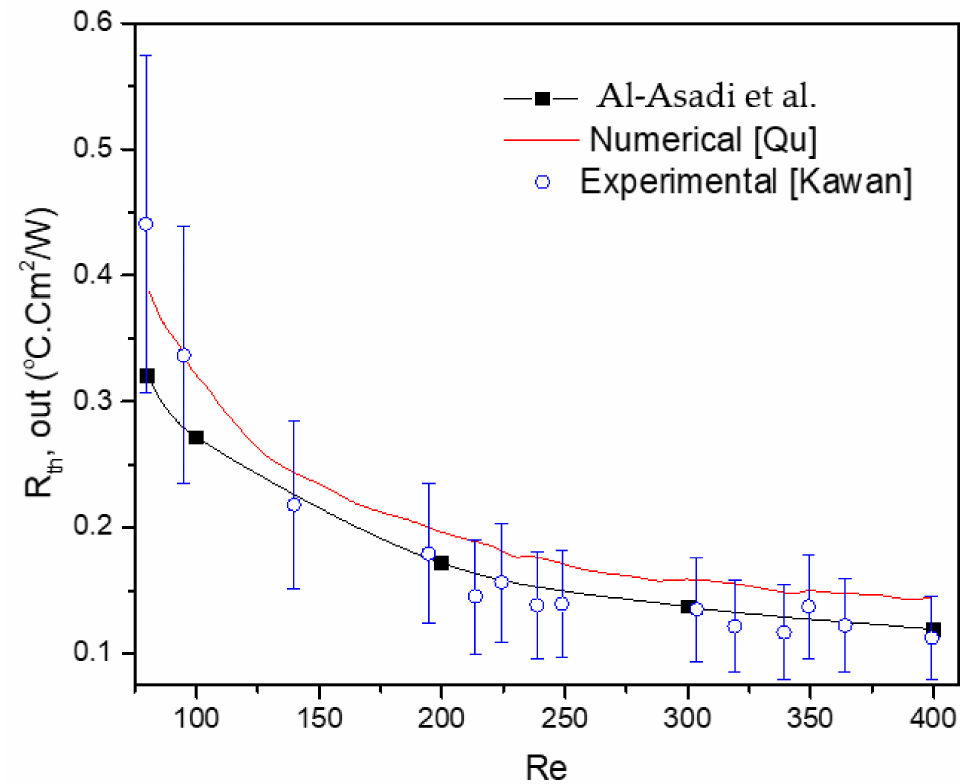
Figure 15. Validation of the present model against experimental data of Kawano et al. [236] © Elsevier, 1998 and alternative numerical results of Qu and Mudawar [235] © Elsevier, 2002 and Al-Asadi et al.